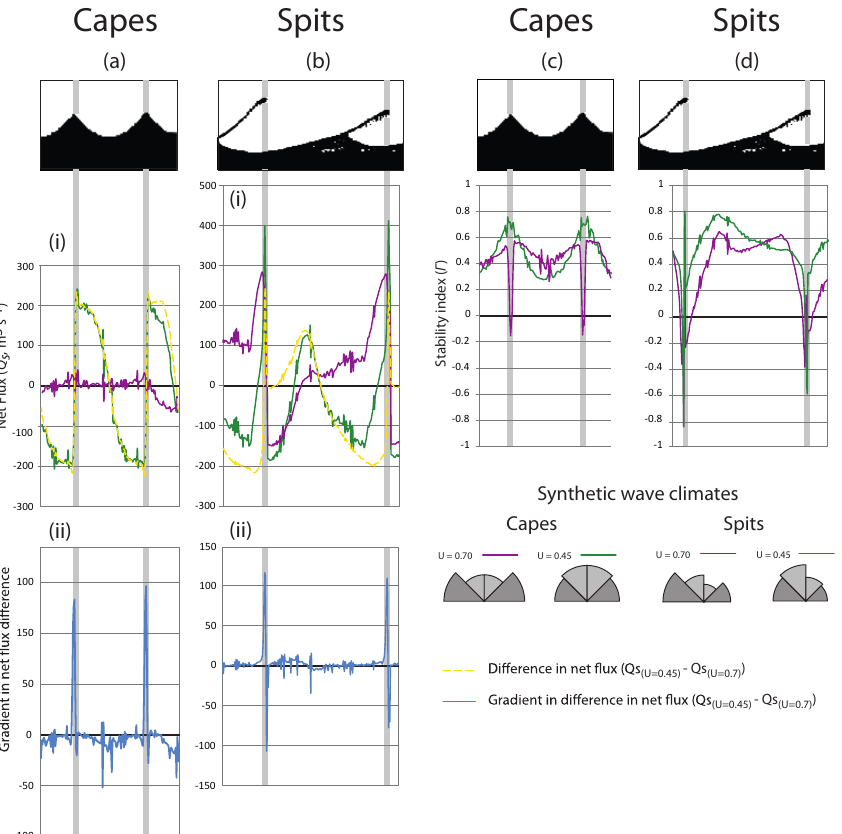
Figure 6. Detailed mapping of potential net flux and stability index across example coastline features for different wave climates impacting on static (unevolving) coastlines. Net flux data for (ai) capes and (bi) spits; blue line: gradients in the difference between the net fluxes for (aii) capes and (bii) spits. Stability index data for (c) capes and (d) spits. Purple line: U = 0 . 7; green line: U = 0 . 45; dashed yellow line: difference in potential net flux. Rose diagrams of the wave climate PDFs are included for